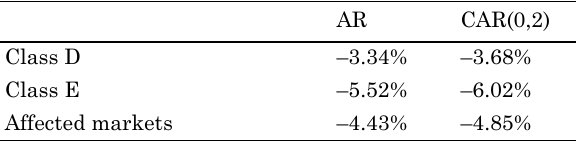
table 7. event study results for the adjustment of